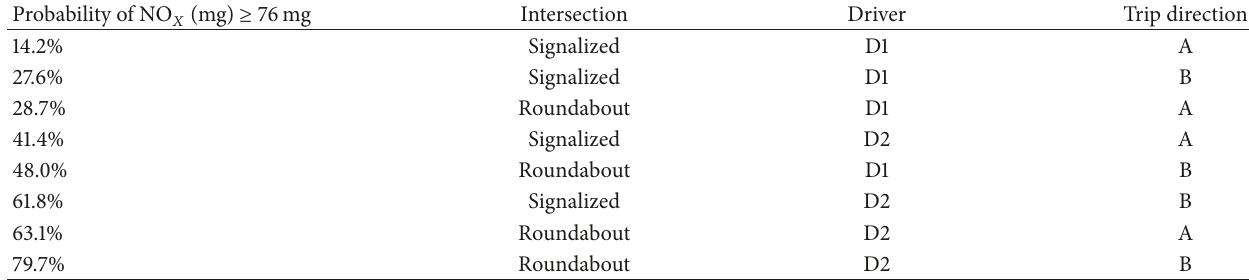
Table 14: Probabilities of NO 𝑋 (mg) ≥ 76 mg (traffic condition =